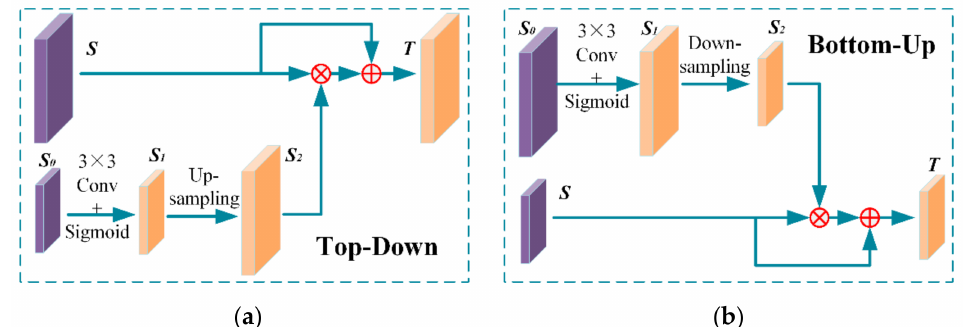
Figure 3. The attention guided feature selection blocks in cross-level attention module. ( a ) The top-down attention block; ( b ) The bottom-up attention block. Feature maps with the same size are multiplied or added in element-wise. These special designs of the attention blocks have greatly improved the performance of detectors, especially for small-scale vehicles. The capital T means the target feature maps and the capital S means the source feature maps. The symbol S 0 , S 1 , S 2 refer to the feature map from the upper or lower layer, the attention mask, and the attention mask with the same size as the source feature map,